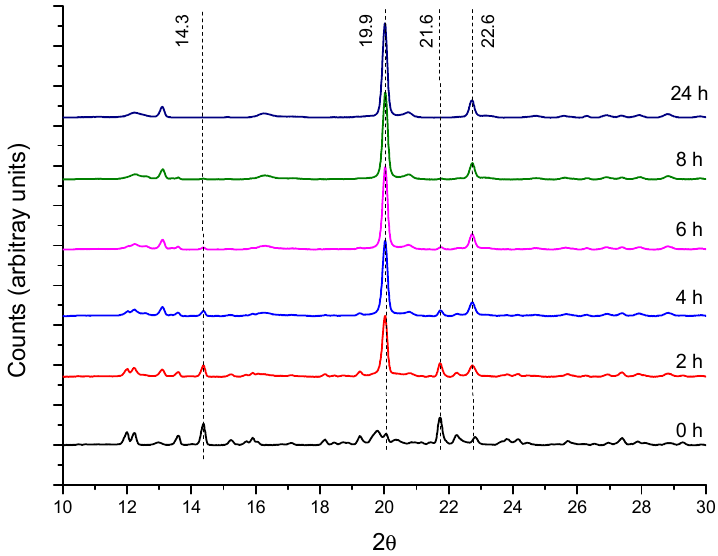
Figure 3. XRD patterns for PEG400: α -CD reaction (1:0.5 feed) at 50 °C as a function of time.